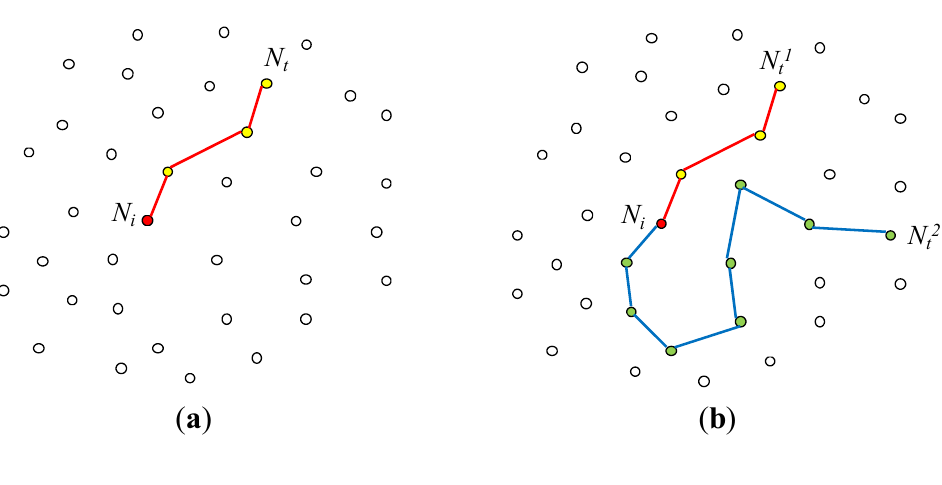
and N is called i t . Each of i